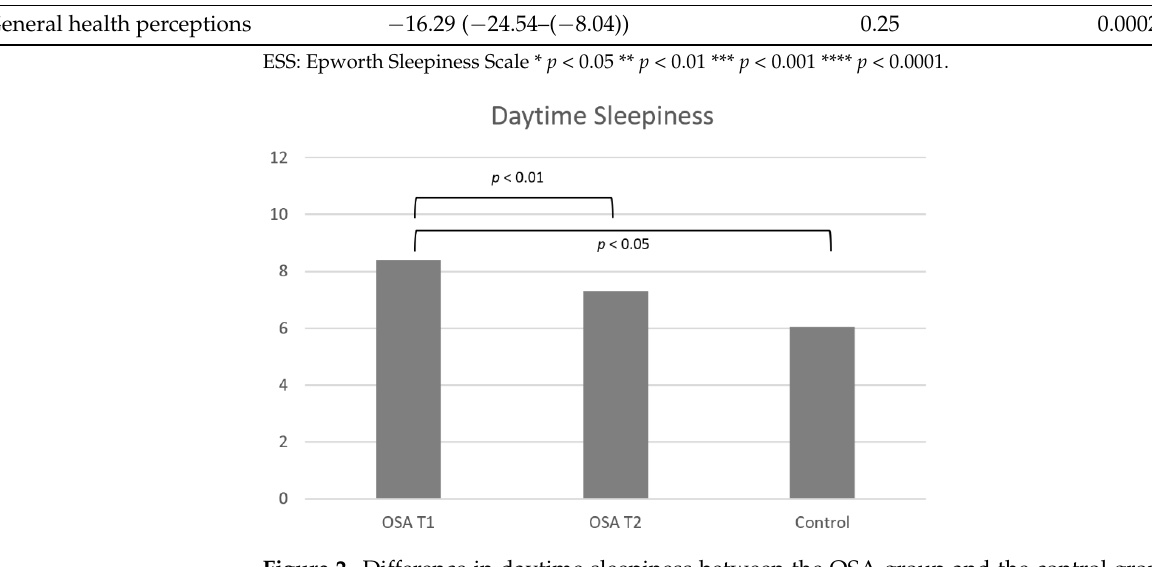
Figure 2. Difference in daytime sleepiness between the OSA group and the control group before MAD treatment (T1) and before (T1) and after (T2) MAD treatment in the OSA group. Significant differences are shown with lines and p values.